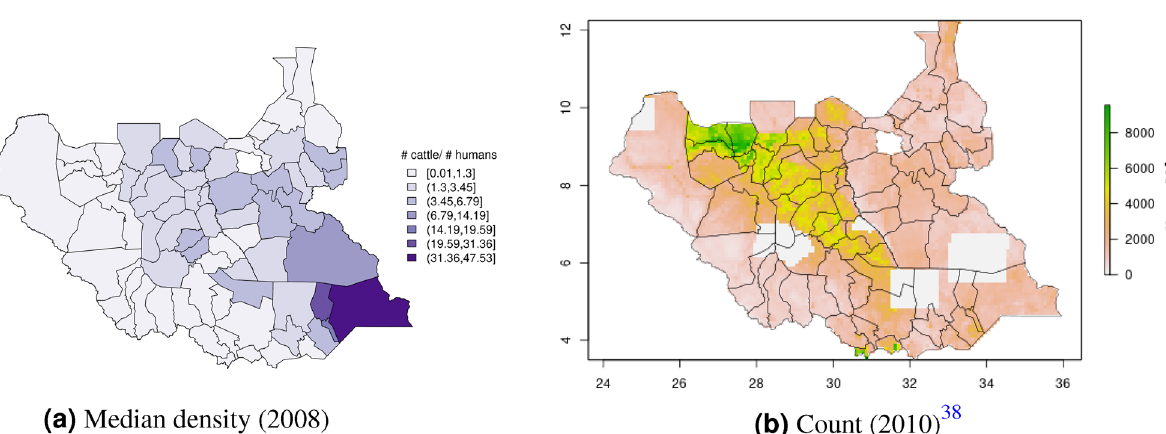
Figure 17. Median cattle density (L, 2008) compared with estimated cattle counts produced by GLW-3 (R, 2010) for South Sudan. Observed density data for 2010 are presented on the left, indicated by circle size; this figure does not represent the contribution of data from other years to the model for 2010 via the temporal random effect, nor the contribution from predictors 16